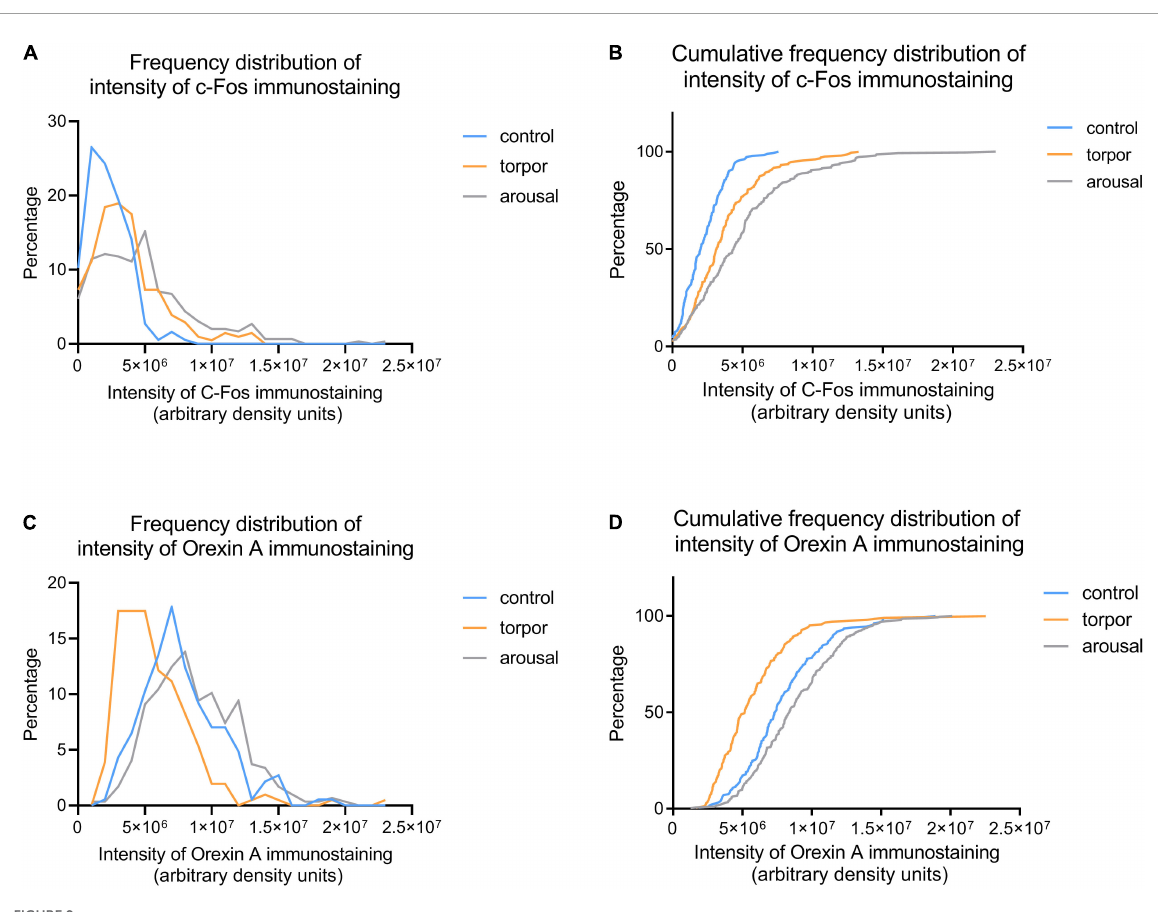
FIGURE9 Frequency (A,C) and cumulative frequency (B,D) plots showing the intensity of C-Fos (A,B) and OXA (C,D) immunostaining of orexinergic neurons in hamsters at euthermia (blue), torpor (orange), and arousal (gray). See Table 4 for Kolmogorov-Smirnov D and p -values.